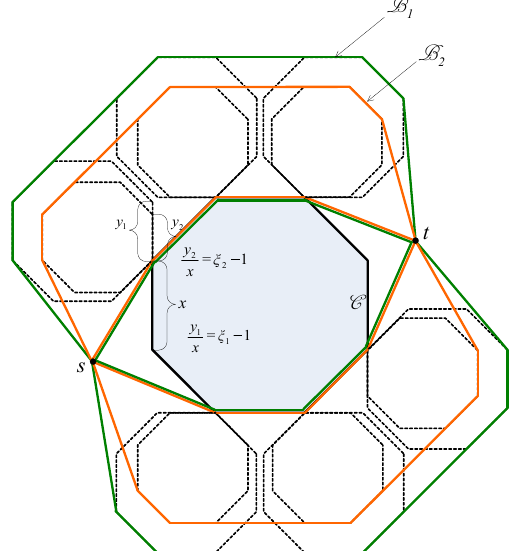
Figure 4. The trajectories of Euclidean routing paths with different values of (cid:101) . The trajectory of Euclidean routing paths when (cid:101) = (cid:101) 1 , is bounded by the green line. The trajectory of Euclidean routing paths when (cid:101) = (cid:101) 2 , is bounded by the orange line